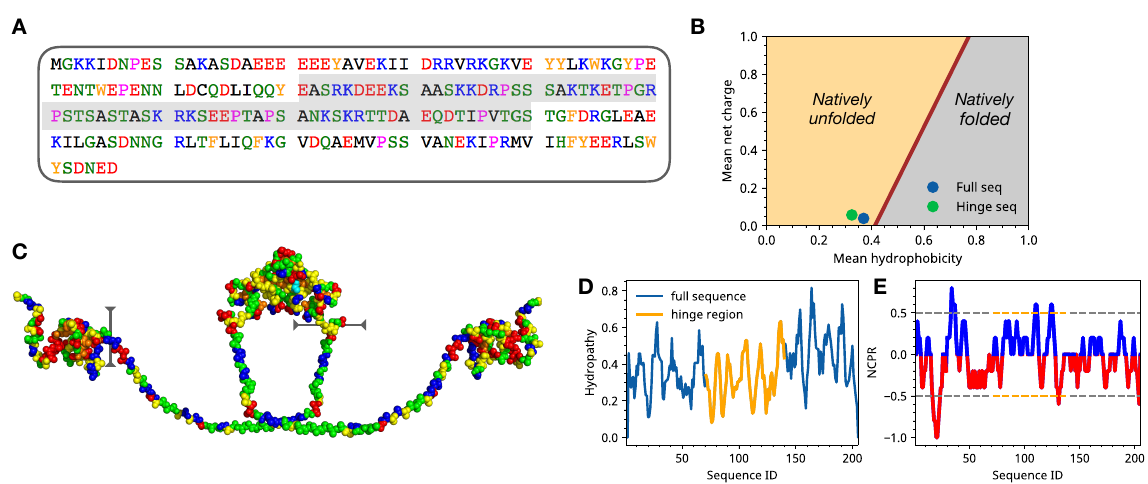
Figure 1. ( A ) Full sequence of a monomeric unit of HP1a. ( B ) The so-called Uversky plot of HP1a sequence showing the positioning of full sequence and hinge regions on a mean hydropathy and mean net charge phase diagram. ( C ) Structure of dimeric HP1a construct showing the hinge region that was used for extensive all-atom simulations. Color coding corresponds to the sequence. ( D ) Sequence-dependent hydropathy. ( E ) Block averaged net charge as a function of the sequence with block size encompassing 4